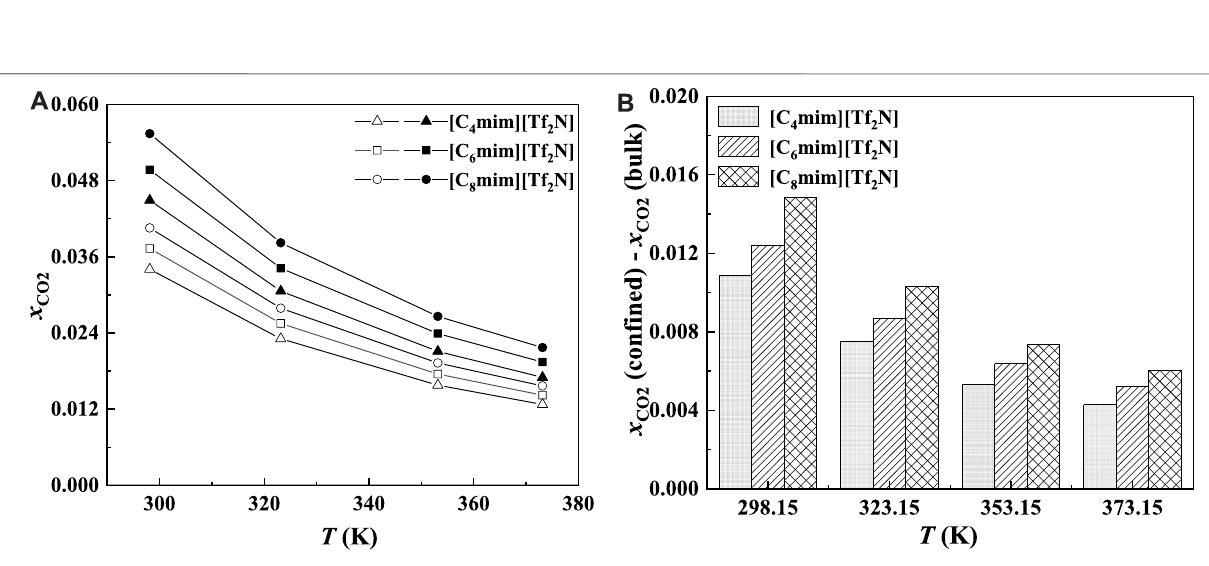
Frontiers in Chemistry |